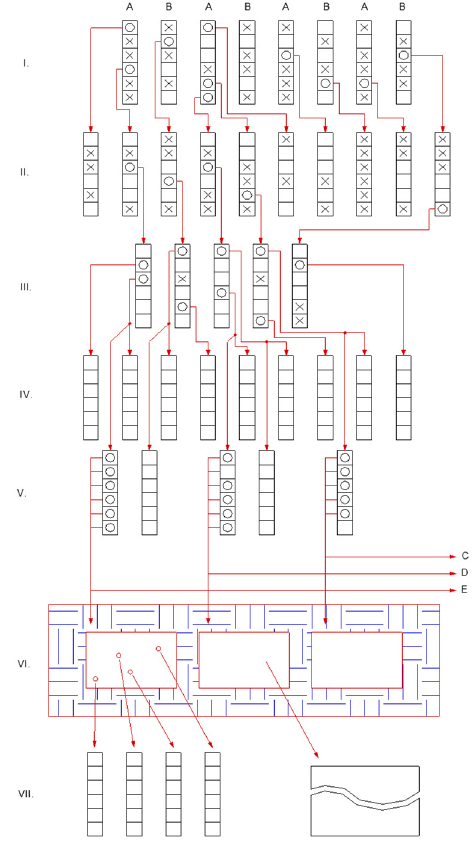
Figure 2. Stages of buckwheat breeding over time. The Roman numerals ( I – VII ) indicate the years (generations) of the breeding. The starting material in the first year is two-parent varieties or populations, indicated as A and B. Both parents are sown in parallel rows. For one parent, after opening the first flower on each plant, the plants with thrum flowers are removed. In the other parent, the plants with pin flowers are removed. So in generation ( I ), only fertilization between A and B flowers is possible, and not fertilization among the plants within each parent. Each square symbolizes a plant, and the plants marked with “x” are removed from breeding, while the plants marked with “o” are selected for further propagation and breeding. Groups of plants with empty squares are those that are used for testing according to the phenotype in the field trial, but not for further propagation or breeding. The best-selected plant material is isolated and taken forward for further propagation or breeding or for submission to official variety testing. In generation ( VI ), the plants are sown in isolation, for evaluation of yield and for propagation. The plant groups C, D, and E are taken on to the first field tests on larger isolated